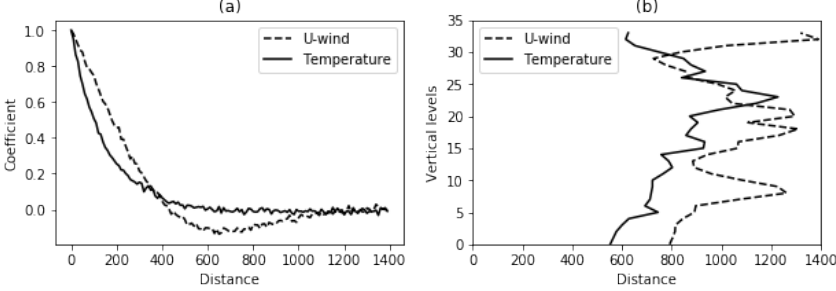
Figure 10. ( a ) Temperature (solid) and zonal wind (dashed) correlations at the surface, ( b ) the corresponding localization radius on the model vertical